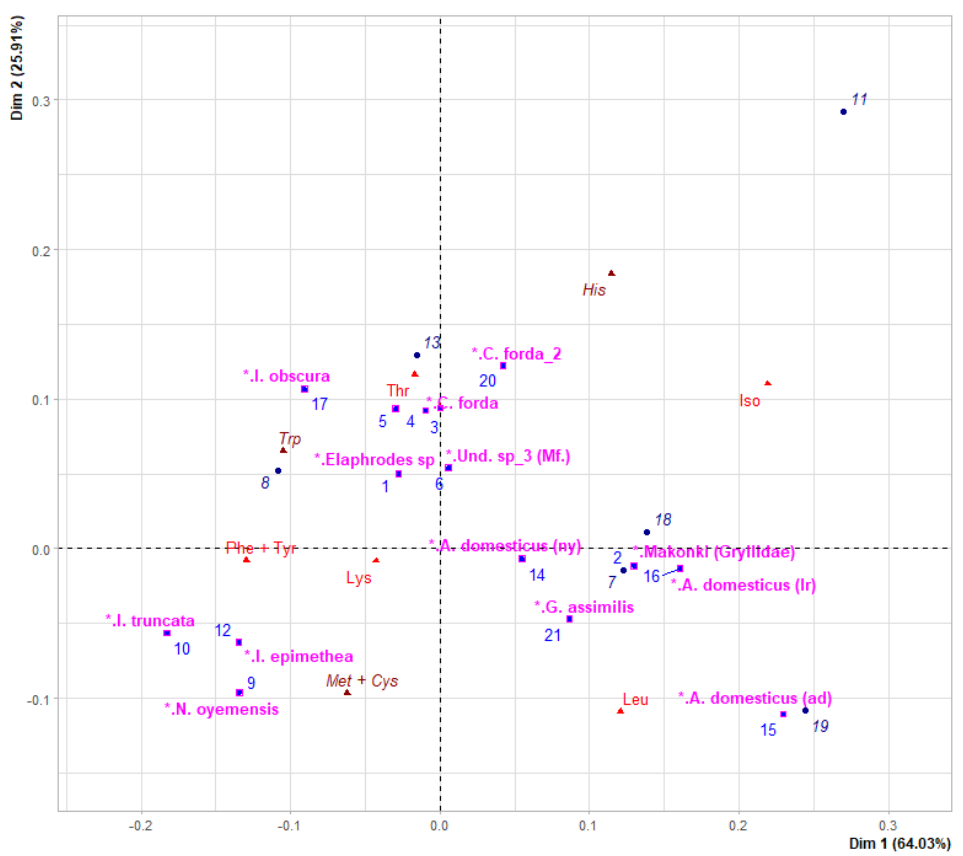
Figure 4. CA graph of the EAA profiles of the studied insects (from 1 to 6) and of selected species derived from the literature (from 7 to 21). Species are as follows: (1) Elaphrodes sp . (“Mingingi”); (2) Und. sp-4 (“Makonki”); (3) C. forda (“Mikwati”); (4) I. ertli (“Misati”); (5) Und. sp-2 (“Binkubala”); (6) Und. sp-3 (“Mifwangi-fwangi”); (7) Gryllus bimaculatus ; (8) Samia ricini (pupae); (9) N. oyemensis ; (10) I. truncata ; (11) I. ertli ; (12) I. epimethea ; (13) Anaphe venata ; (14) A. domesticus (nymphs); (15) A. domesticus (adults); (16) A. domesticus (larvae); (17) I. obscura ; (18) Gryllodes sigillatus ; (19) Schistocerca gregaria ; (20) C. forda ; (21) G. assimilis . The full names of species derived from the literature are given